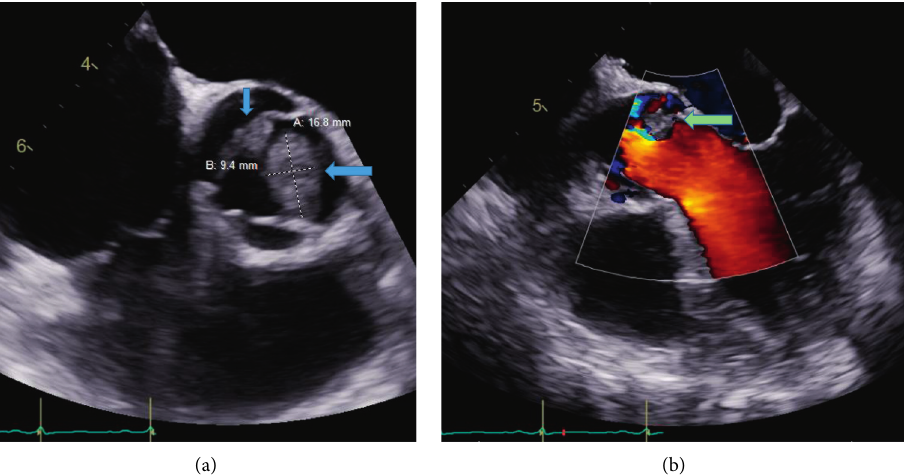
Figure 2: (a) TEE image showed large vegetation (large blue arrow) and another small vegetation (small blue arrow). (b) TEE color Doppler showed AV regurgitation and the vegetation over the valve leaflet (green